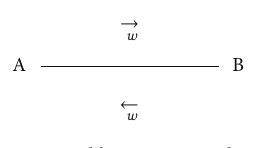
Figure 1: Bond between two